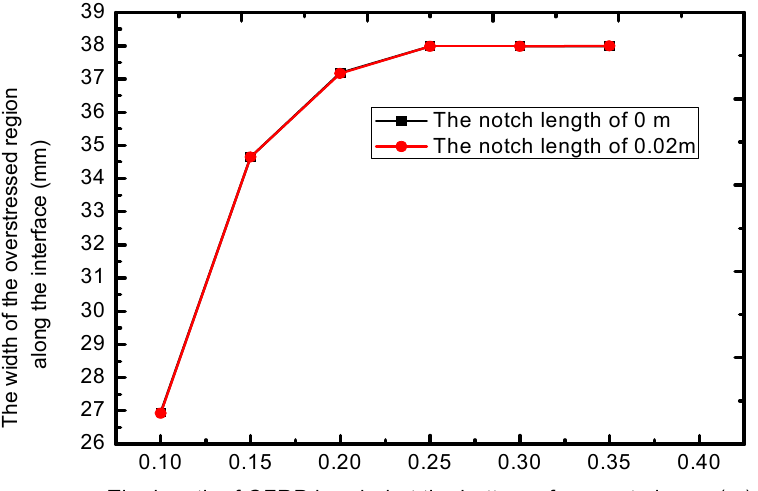
Figure 11. The plot of the width of the overstressed region along the interface against the length of bonded